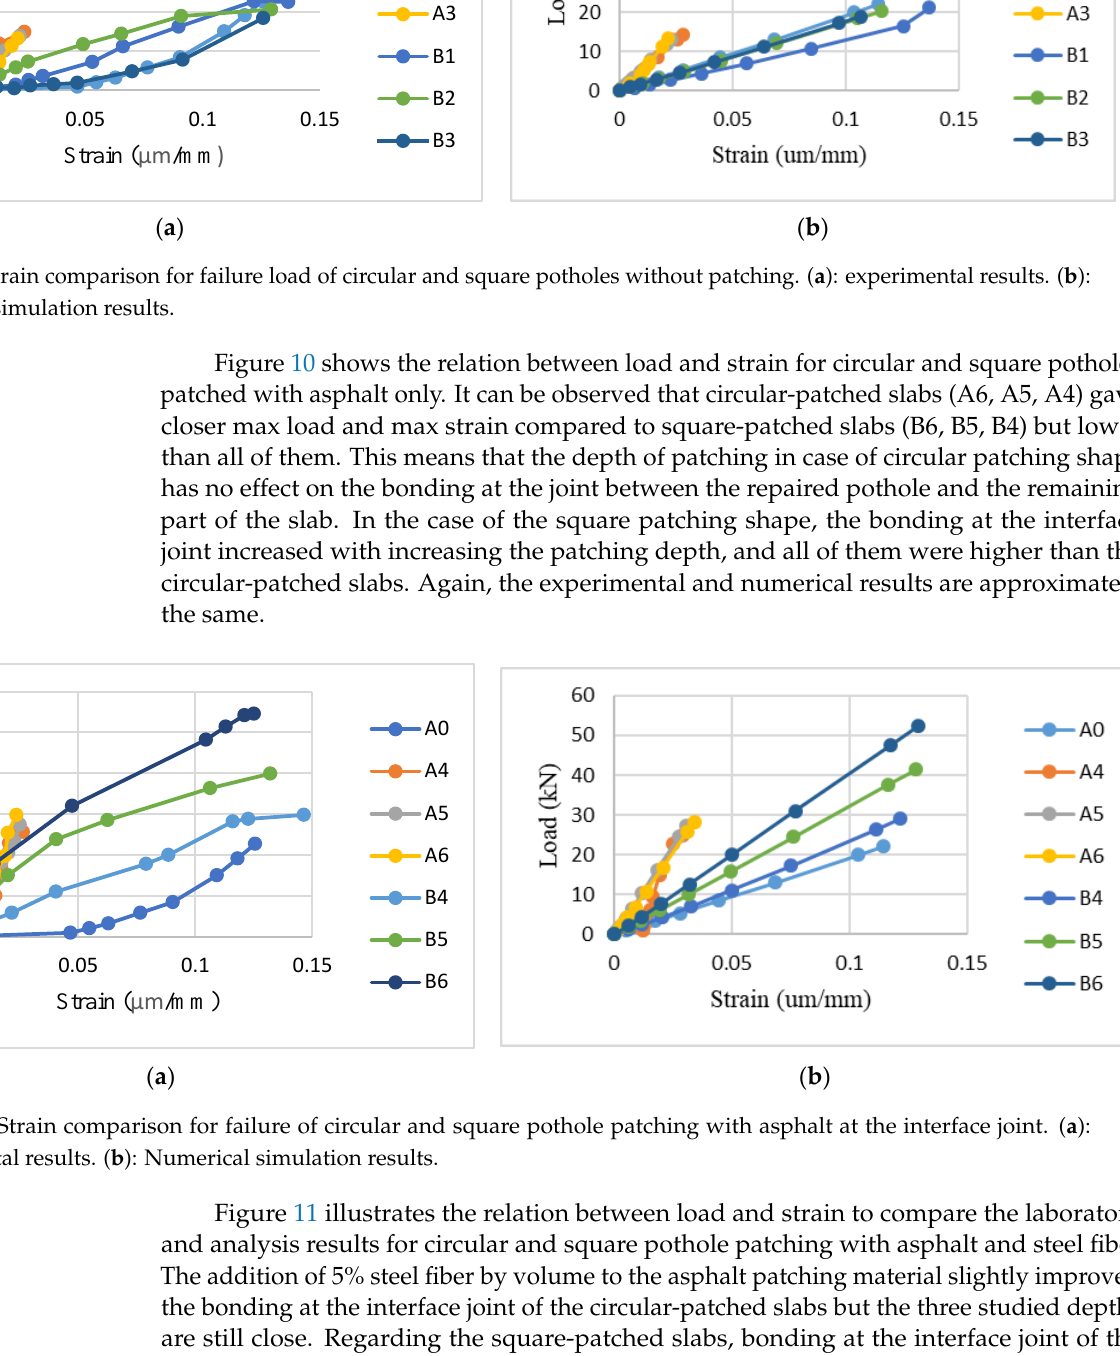
Figure 11. Strain comparison for failure load of circular and square pothole patching with asphalt and steel fiber at the interface joint. ( a ): Experimental results. ( b ): Numerical simulation results. 3.2. Comparison between Laboratory Max Load and FEA Max Load A comparison of the max values of load for the nineteen tested specimens obtained experimentally and analytically is presented in Table 12. Generally, there is good agree- ment between the experimental and numerical maximum loads with a mean value of 4.3% difference. It can be observed that specimens with square potholes (B7, B8, B9) in all cases give closer max load compared to circular potholes (A7, A8, A9). Slab B9 increased the max load compared to slab A0 by a mean value 61.7% for experimental and 61.58% for numerical due to steel fiber, which increases the failure load of slabs.